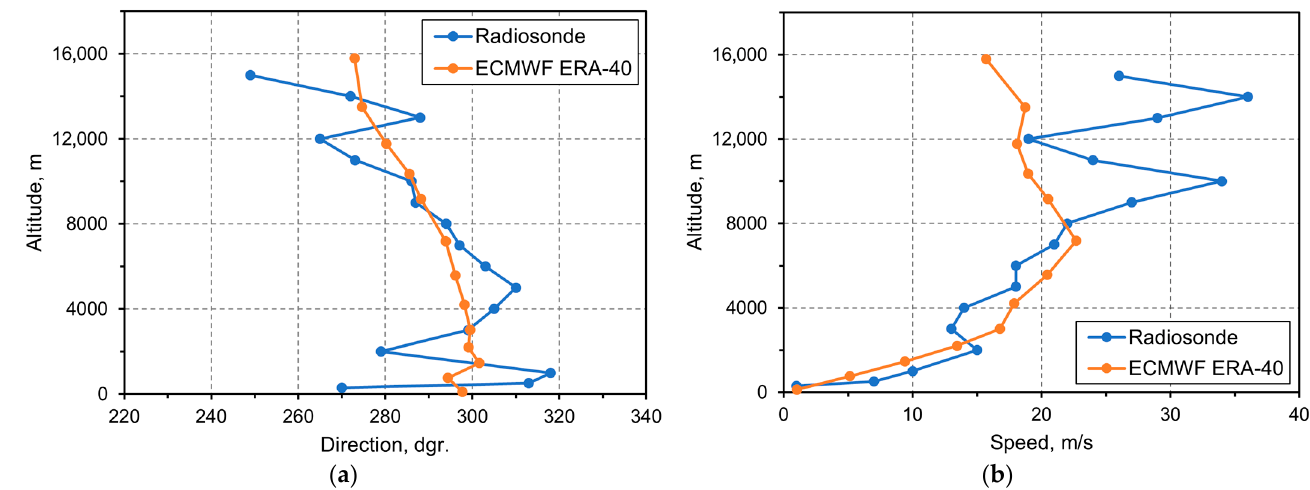
Figure 5. Wind characteristics according to the RSM00032389 station measurements (at 17:30 UTC on 12 November 1964) and to the ECMWF ERA-40 reanalysis data (at 18:00 UTC on 12 November 1964): ( a ) Direction; ( b ) Speed.